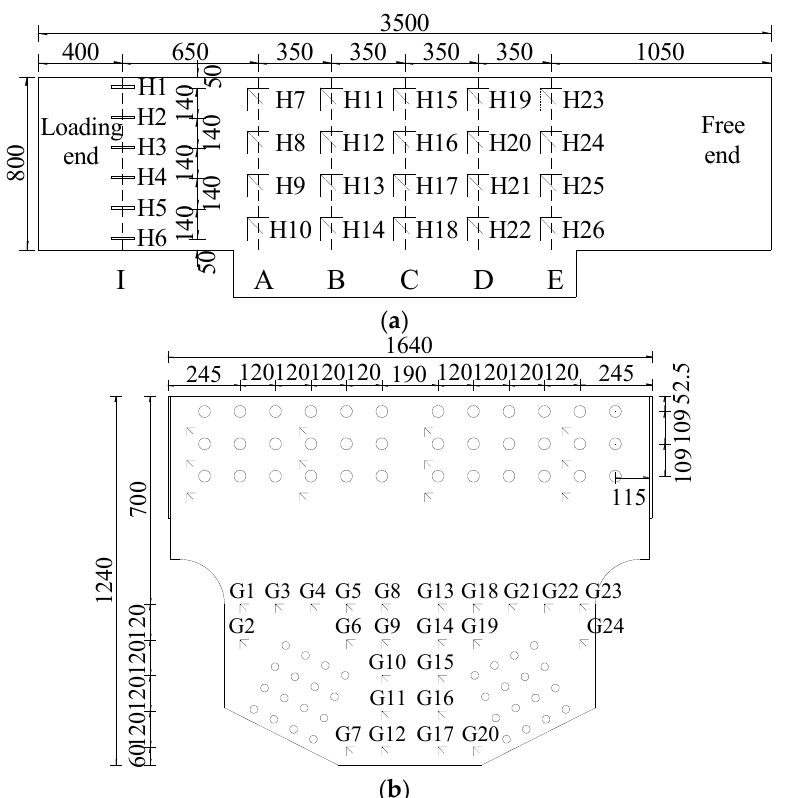
Figure 7. Schema of the test setup.